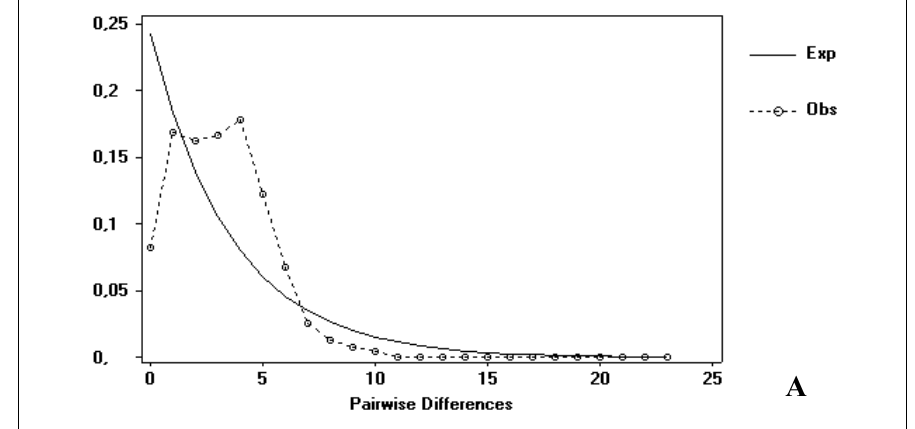
Figure 1. Mismatch distribution (pairwise sequence differences) for the mitochondrial control gene for the Sotalia guianensis population analyzed. ( A ) Assuming a constant population size; ( B ) Assuming a population expansion. The analysis showed a clear and significant population